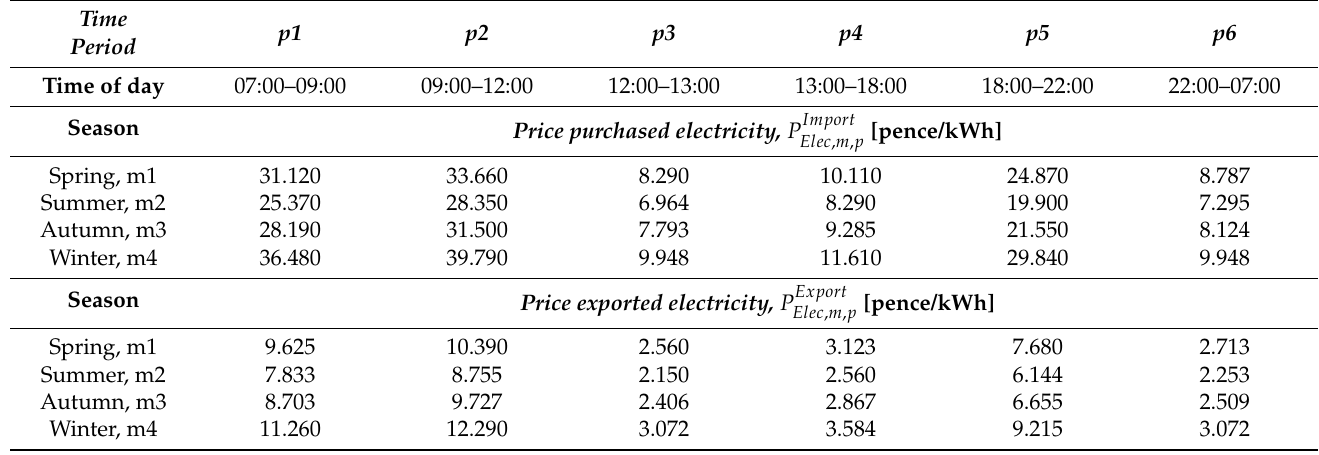
Table 5. Cost of imported and exported electricity, per time of day and year.